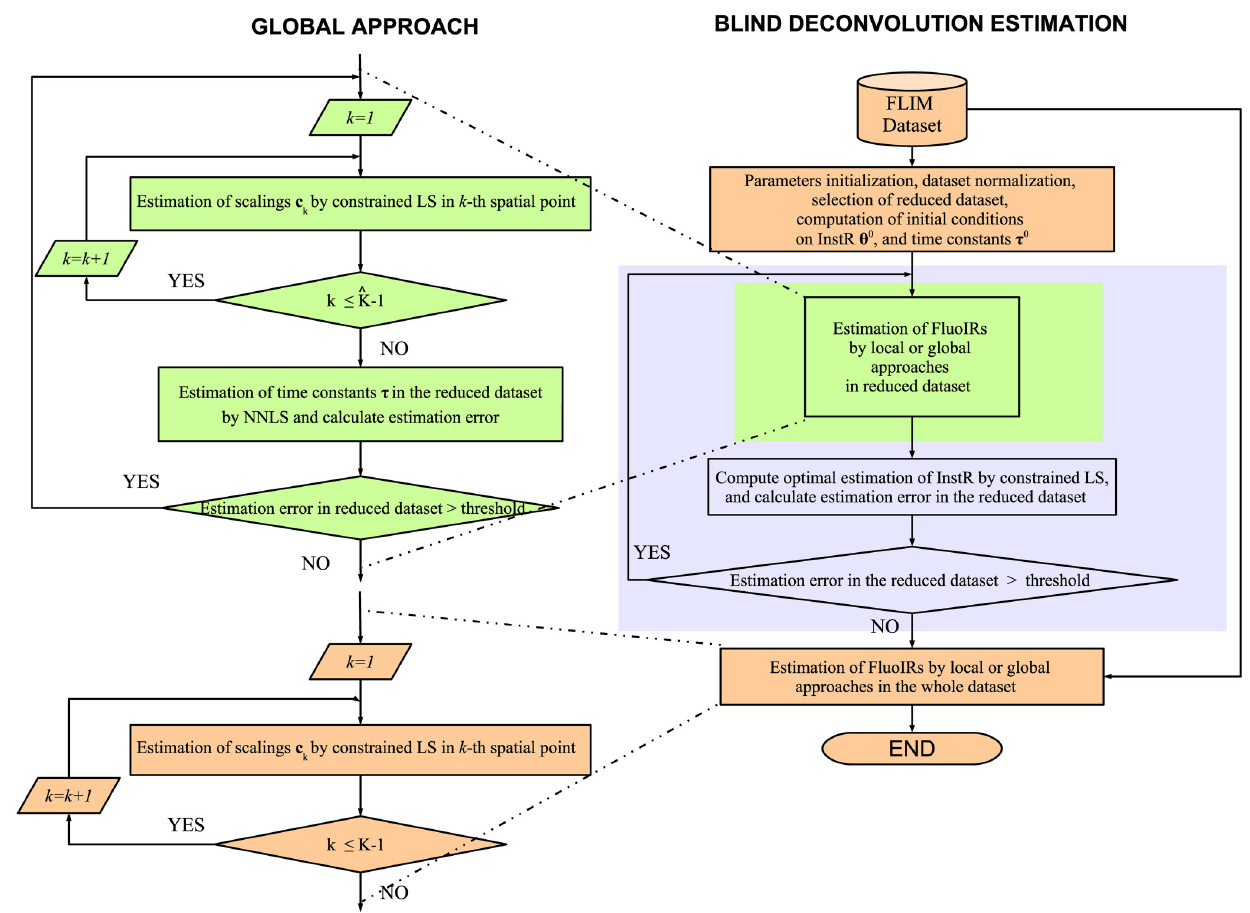
Fig 3. Blind deconvolution estimation: Global approach. Block diagram of the general methodology with global approach to estimate FluoIRs.